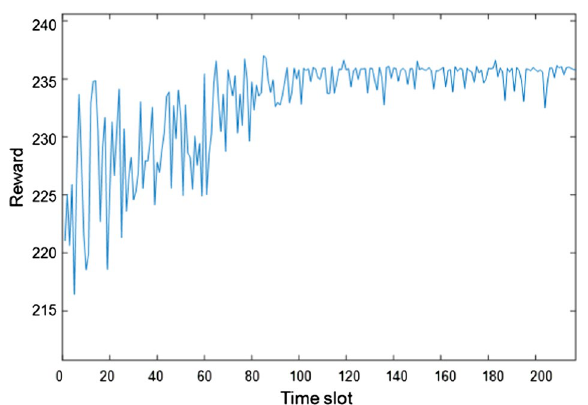
Fig. 11 Learning and training process of DRL